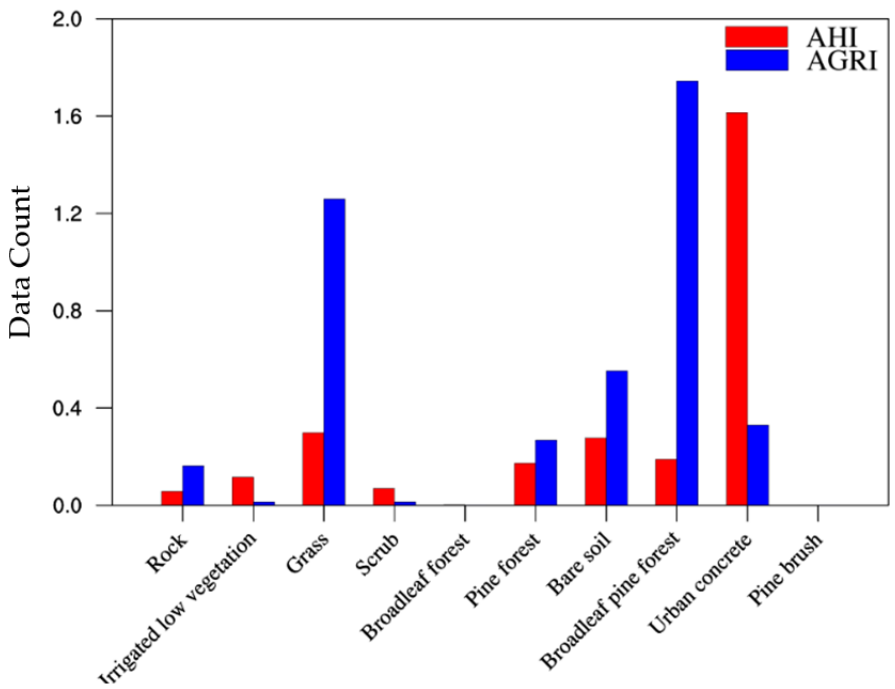
Figure 5. Numbers of different vegetation types present in the AGRI (divided by 10 6 ) (blue bars) and AHI (divided by 10 8 ) (red bars) one-month